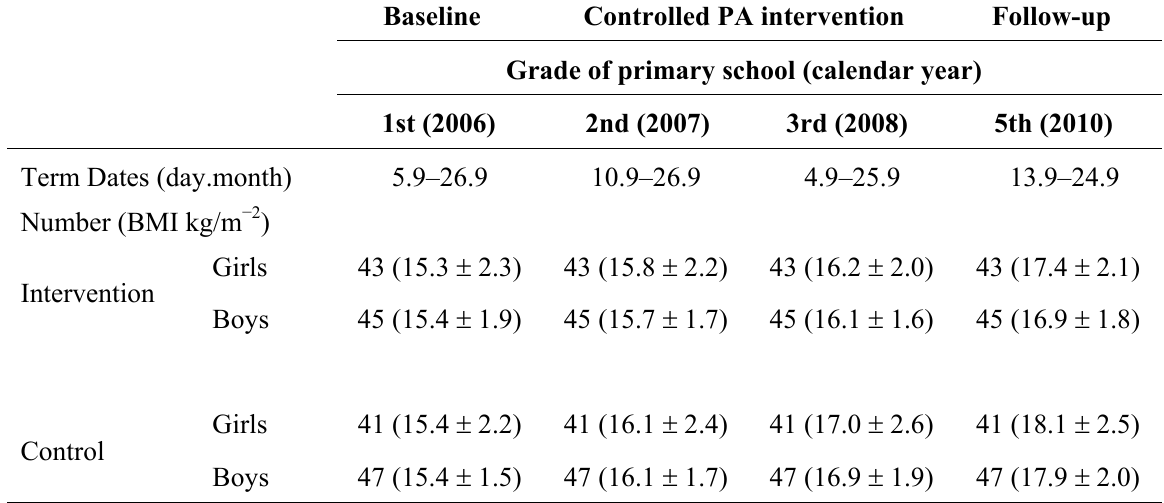
Table 1. School term dates of PA monitoring, numbers and BMI (M ± SD) of participants during the years